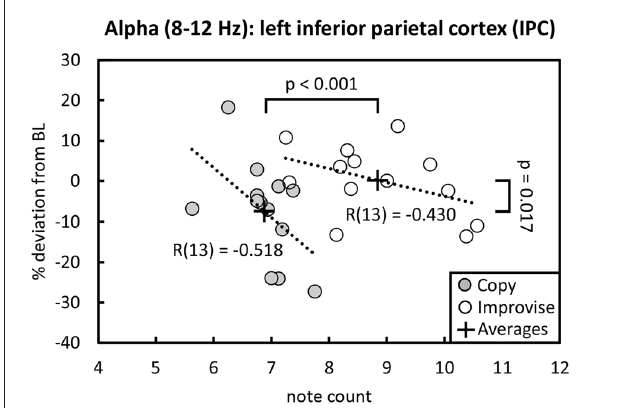
FIGURE 5 | Alpha activity vs. note count. Improvise exhibited higher levels of alpha activity than Copy despite having higher note count, and despite a trend within each condition towards lower alpha levels with increasing note count. Trend lines are based on Pearson’s correlation